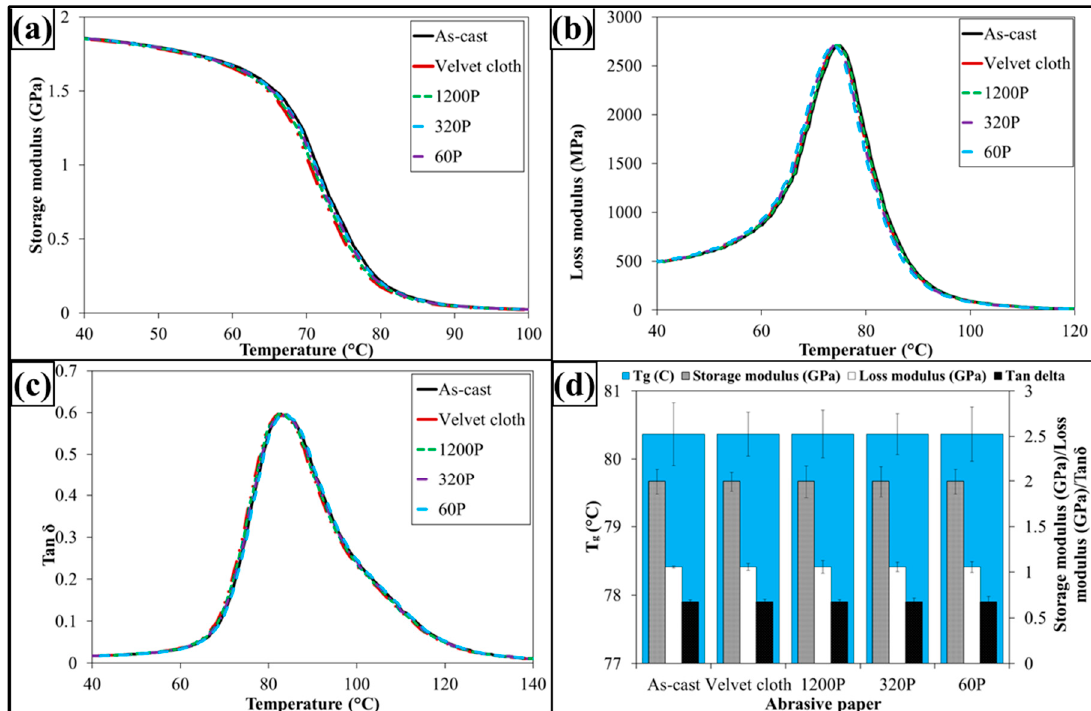
Figure 17. Dynamic mechanical properties of 0.05 wt % MLG-0.05 wt % clay-EP nanocomposites: ( a ) storage modulus; ( b ) loss modulus; ( c ) loss factor (Tan δ ); ( d ) glass transition temperature ( T g ), storage modulus, loss modulus and Tan δ values corresponding to T g .